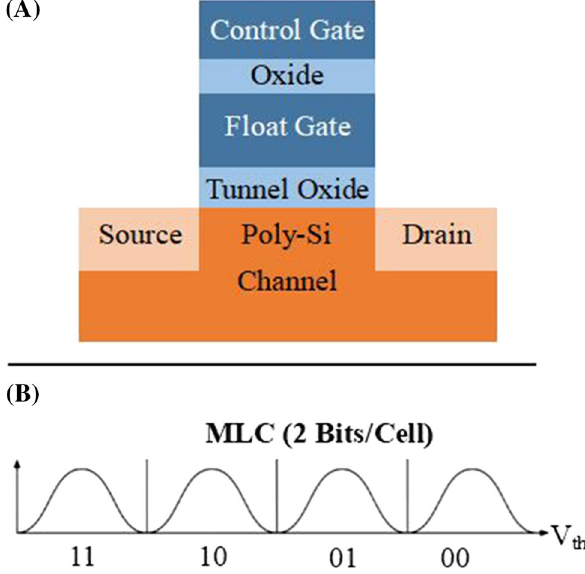
Fig. 1 A Overview of NAND flash cell B MLC flash chip